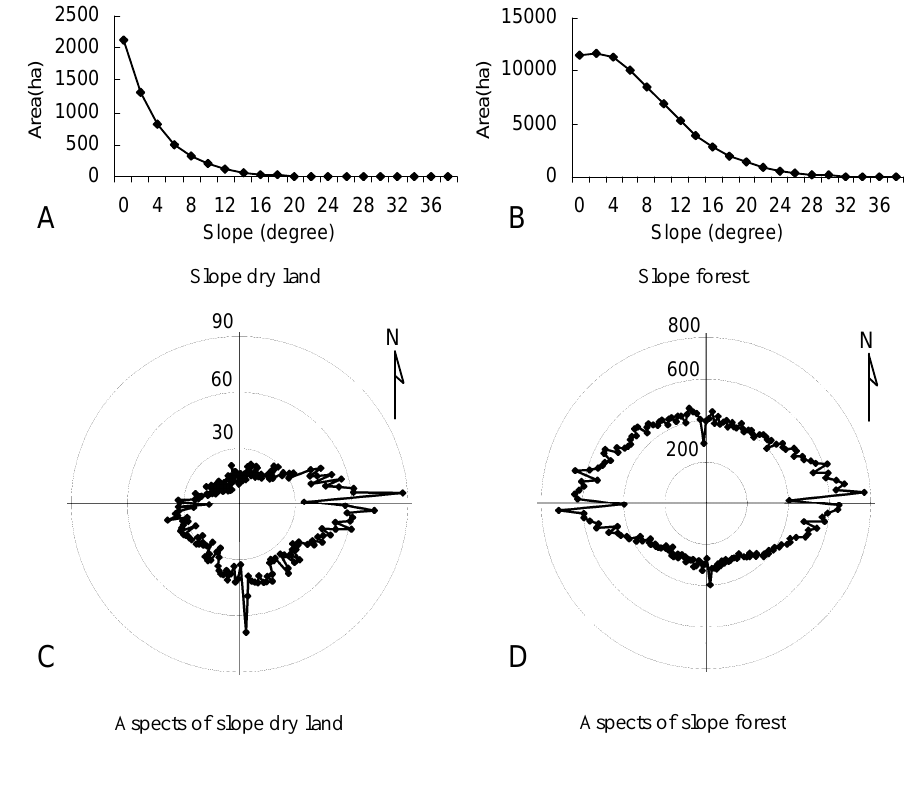
Figure 6. Land transformation between dry land and forest on sloped land over 4